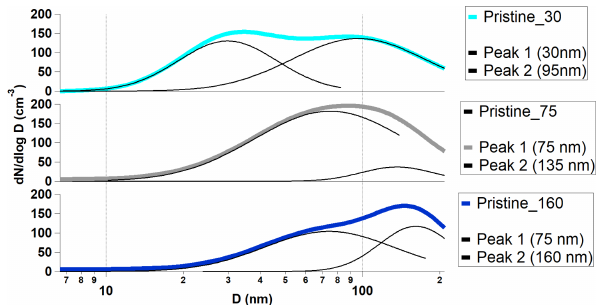
Figure 3. Peak fitting of the three pristine k -mean aerosol cate- gories. D: